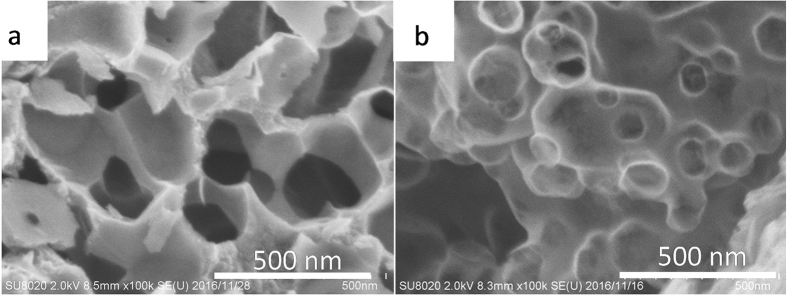
FE-SEM images of (a) MgOCmacro and (b) MgOC50.